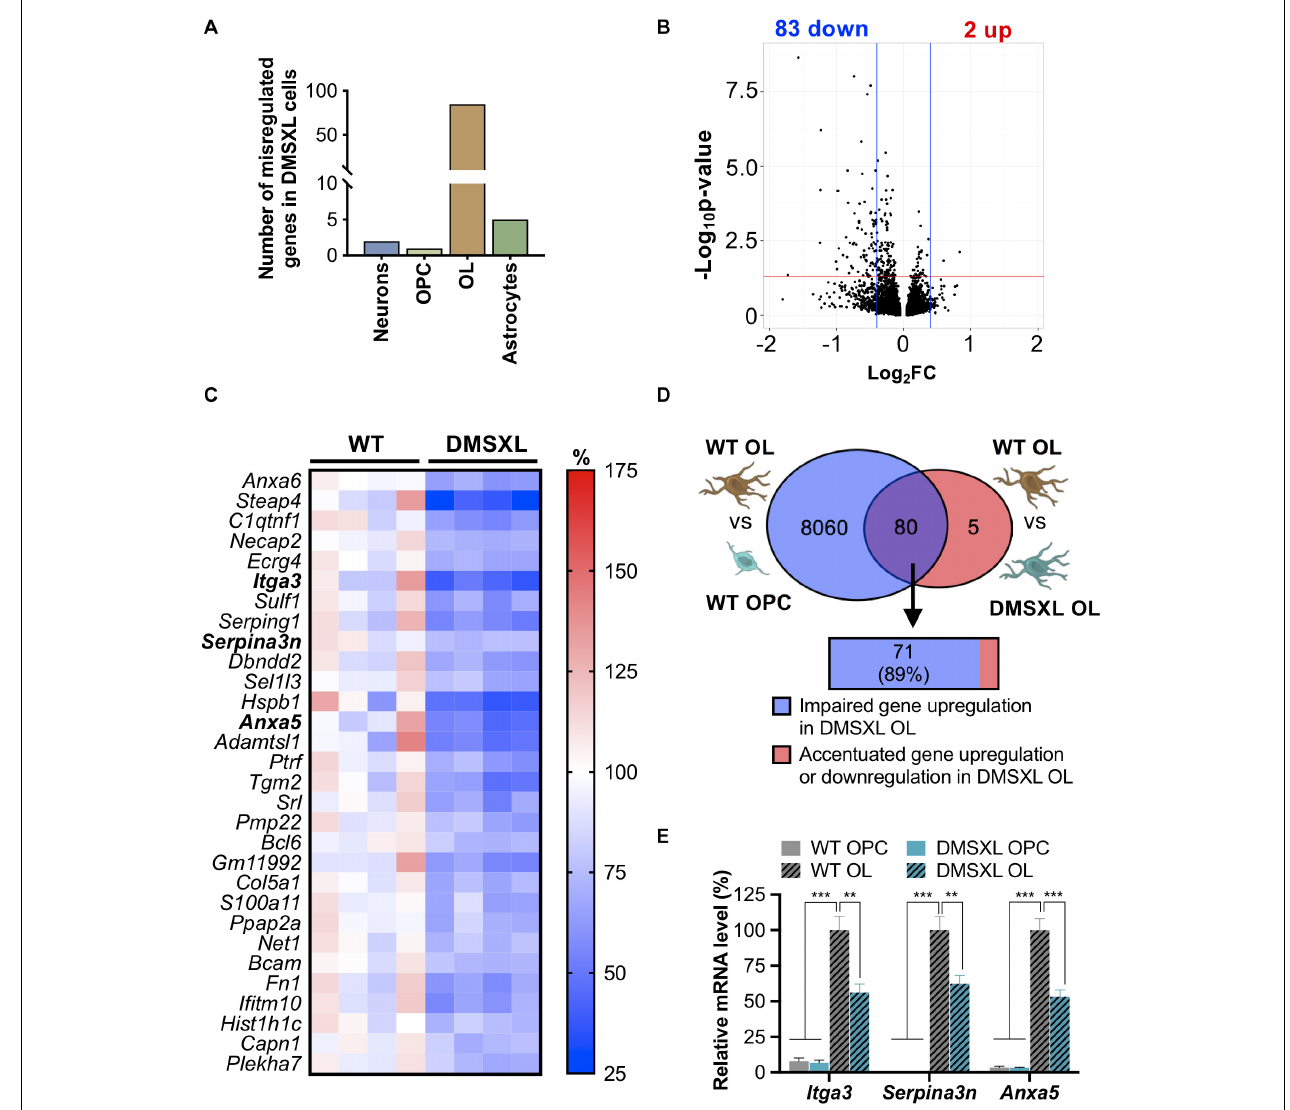
FIGURE 3 | Expression changes in DMSXL brain cells and impaired upregulation of gene expression in oligodendroglia. (A) Number of genes differentially expressed in each DMSXL brain cell type. Inclusion criteria: absolute fold change > 1.4; p (corrected for multiple comparisons) < 0.05. Total number of gene transcripts identified: neurons, 17,089; OPC, 15,845; OL, 16,070; Astrocytes, 16,878. (B) Volcano plot representing the dysregulated transcripts in DMSXL OL, showing that most of the expression defects resulted in gene downregulation, when compared to WT controls. (C) Heatmap representing the expression changes of the 30 most significantly affected genes in DMSXL OL, relative to normalized expression in WT OL. Inclusion criteria: absolute fold-change > 1.4, p (corrected for multiple comparisons) < 0.001, and base-mean expression value > 50. Genes highlighted in bold were validated by RT-qPCR. (D) Overlap of the 85 expression changes in DMSXL OL with the variations that accompany WT oligodendroglia differentiation in culture (representation factor: 2.4, p < 1.9E-27). The majority of the overlapping genes failed to upregulate their expression to match the levels of WT OL (Fisher’s exact test, p < 0.001). (E) RT-qPCR quantification of Itga3 , Serpina3n , and Anxa5 transcripts in DMSXL OL, confirming lower total expression relative to WT cells after differentiation in culture (** p < 0.01; *** p < 0.001; one-way ANOVA; n = 3 OPC; n = 6 OL independent cultures per